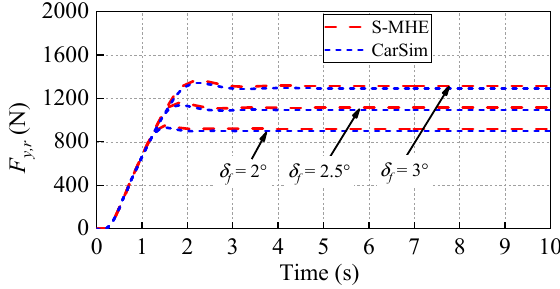
Figure 11. Lateral tire force at rear tire estimated by S-MHE.